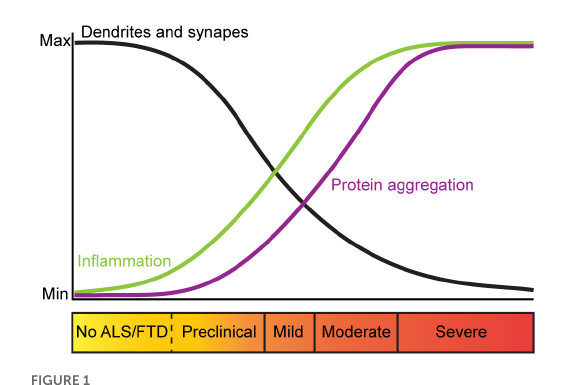
FIGURE1 Trajectory of pathological changes and corresponding clinical presentation in ALS and FTD. Trajectory of changes in dendritic branches and synapses in ALS and FTD (black), inflammation (green) and protein aggregation (purple) relative to clinical symptoms of ALS and FTD. In ALS and FTD, dendritic branches and synapses are lost prior to clinical onset of disease, suggesting that perturbed neuronal morphology and synaptic maintenance are mechanisms that trigger synaptic loss and neurodegeneration associated with these